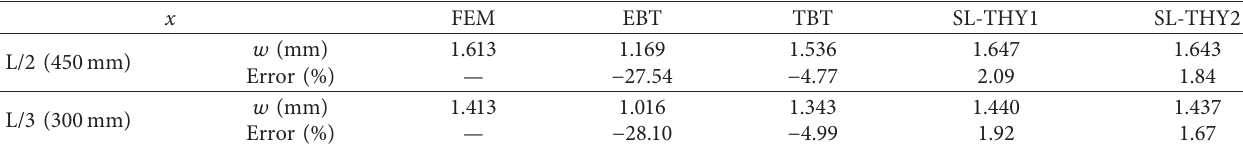
Figure 10: Comparison of vertical deflections predicted by the proposed methods (SL-THY1 and SL-THY2), EBT, TBT, and FEM analysis for the simply supported box girder (example 1). Table 2: Vertical deflections of midspan and 1/3-span of a simply supported box girder